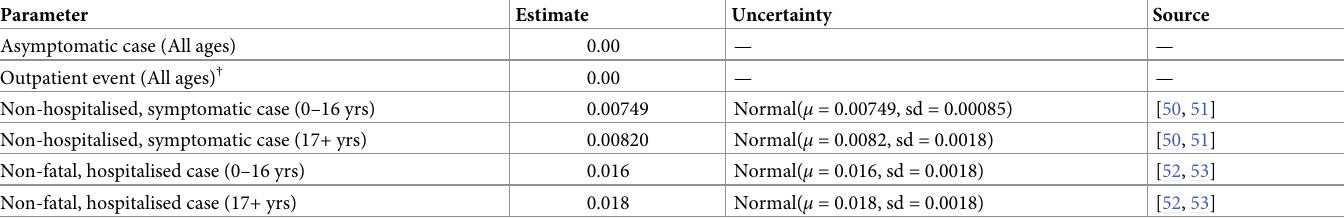
Table 5. Non-fatal case decrements in health